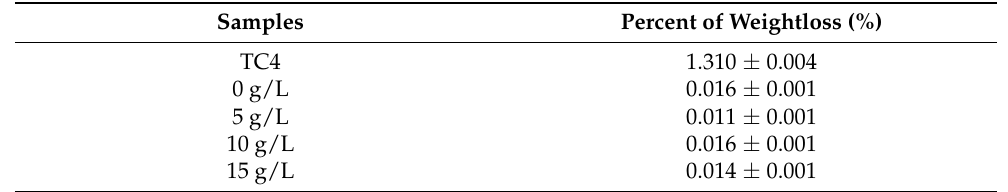
Figure 5. Friction coefficient curves of TC4 and MAO-Cu/Cu-(HEA)N composite coatings with different CuSO 4 concentrations. Table 3. Percent of weight loss of TC4 and MAO-Cu/Cu-(HEA)N composite coatings with different CuSO 4 concentrations.